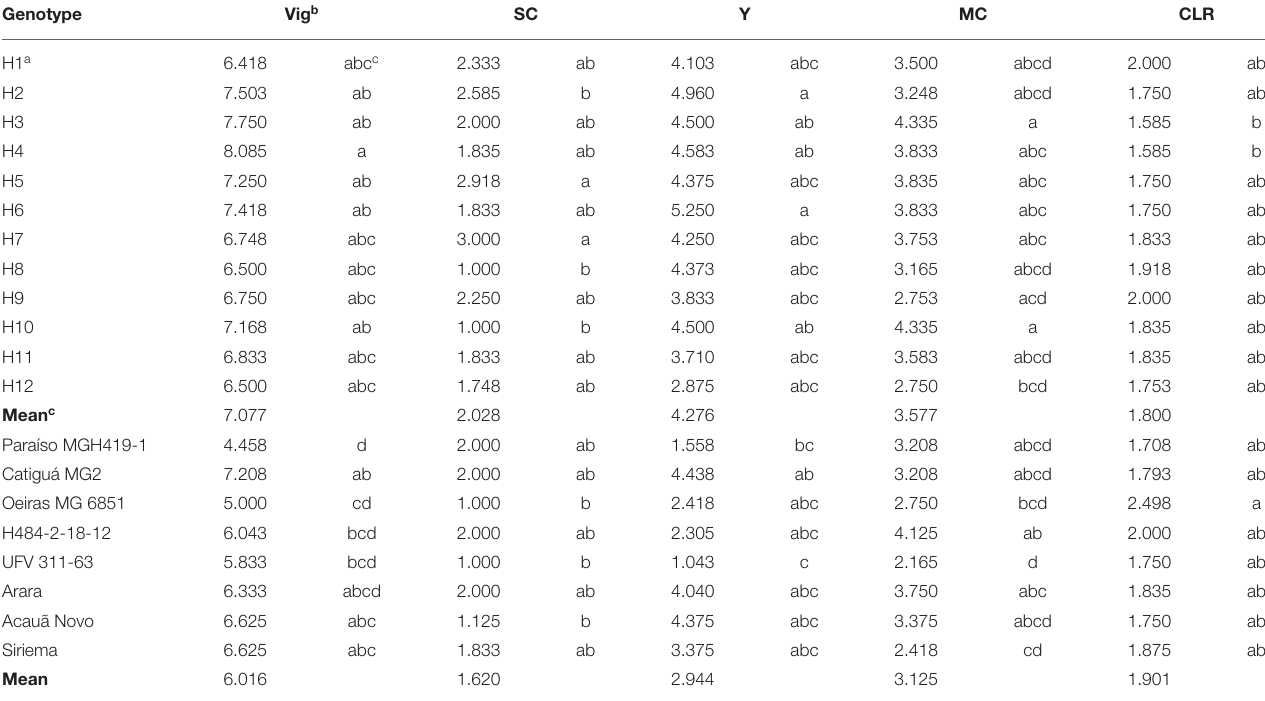
TABLE 10 | Means of five agronomic traits, evaluated in F 1 hybrids (H1–H12) obtained in a circulating diallel scheme and the respective parents of arabica coffee trees, in Viçosa, state of Minas Gerais, Brazil.